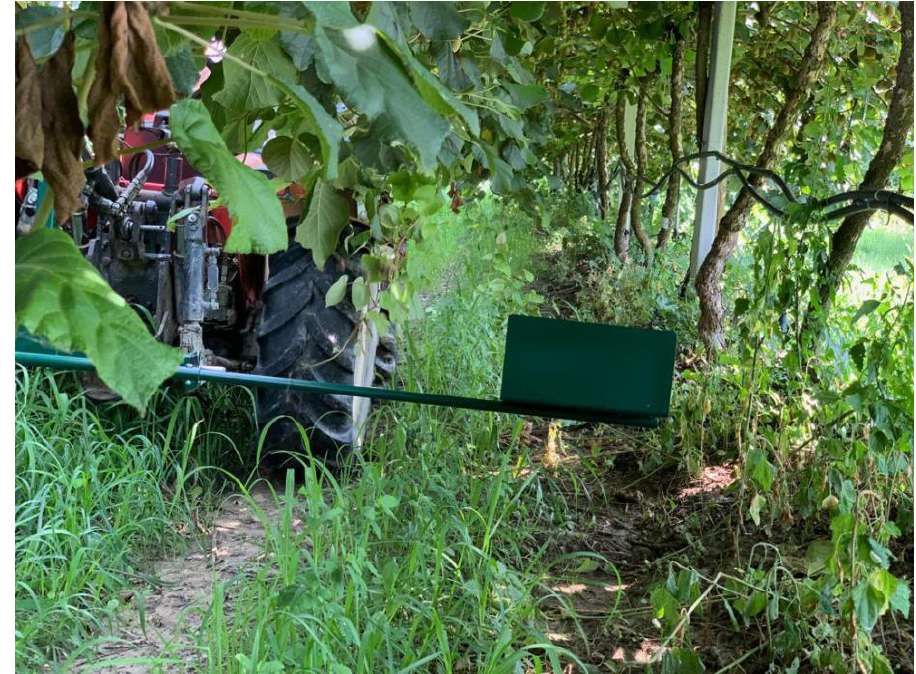
Figure 4. Camera position during the acquisition.